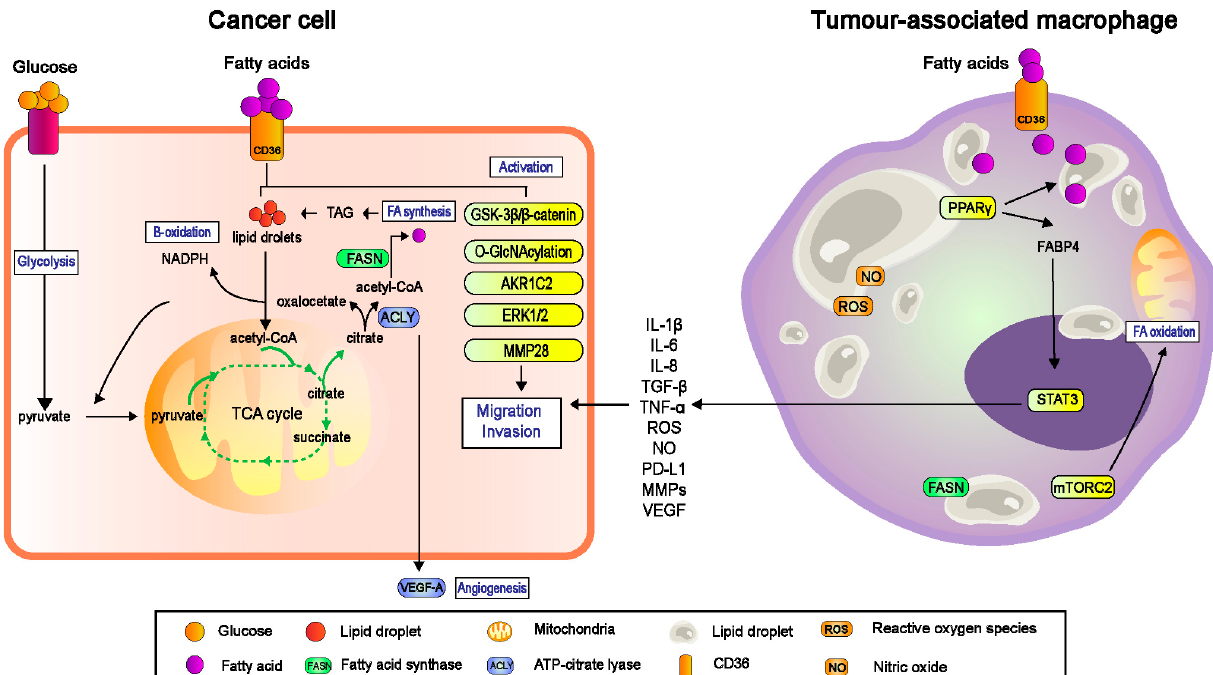
Figure 2. The bidirectional interaction between cancer cells and macrophages regulated by CD36 receptor in promoting metastasis. Due to hypoxic conditions, cancer cells in tumour microenvironment (TME) increase the uptake of exogenous fatty acids for survival, energy source and rapid proliferation. Depending on the type of cancer, literatures have mentioned CD36 promotes metastasis, invasion and angiogenesis by activating the downstream GSK-3 β / β -catenin, O-GlcNAcylation, AKR1C2, ERK1/2 and MMP28 signalling pathways. However, the recruitment of macrophage to TME and become tumour-associated macrophages (TAMs) is significant for cancer progression. TAM tends to have a higher level of FA uptake and accumulation via CD36, which accordingly enhance the fatty acid oxidation (FAO) of TAMs to generate more energy. This phenomenon also upregulates the lipid biosynthesis to produce more nitric oxide (NO) and reactive oxygen species (ROS) and secrete high level of immunosuppressive cytokines such as interleukin-6 (IL-6), interleukin-8 (IL-8), tumour necrosis factor- α (TNF- α ) and more. The dynamic interaction between cancer cells and TAMs constantly favouring the tumour evasion and ultimately metastasis. NADPH, nicotinamide adenine dinucleotide phosphate; TAG, triacylglycerol; VEGF, vascular endothelial growth factor; MMPs, matrix metalloproteinase; PPAR γ , peroxisome proliferator- activated receptor gamma; FABP4, fatty acid-binding protein; STAT3, signal transducer and activator of transcription 3; mTORC2, mammalian target of rapamycin complex 2.